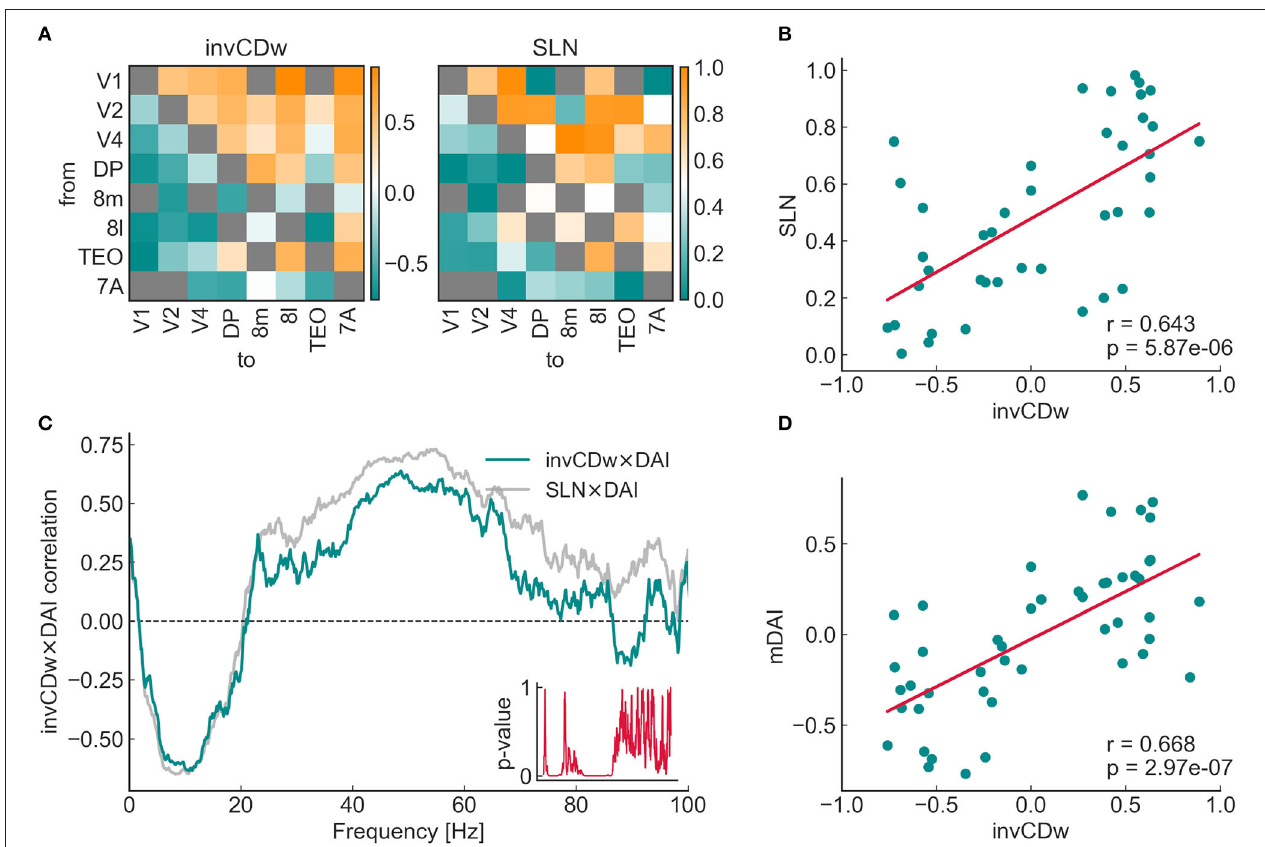
FIGURE 6 | Relationship of the additive inverse of the weighted convergence degree (invCDw) with the SLN (fraction of supragranular labeled neurons) and the DAI (directed influence asymmetry index, see the main text for complete descriptions) in the 8 × 8 subgraph. (A) The invCDw and the SLN matrices of the 8 × 8 subgraph, the latter based on the data from Markov et al. (2014), as in Mejias et al. (2016). Both distributions are highly asymmetric. Both are ordered according to the anatomical (SLN-based) hierarchy, therefore it shows that for this subgraph, convergent edges highly coincide with feedforward connections (upper triangle from the diagonal), while divergent edges coincide with feedback connections (lower triangle). It is also clear just by looking at the color distributions, that area TEO would be much lower, while frontal eye field areas 8m and 8l would be higher according to the CD-based ranking. Gray cells are NaNs, where there is no edge in the graph. (B) There is a significant positive correlation between the SLN and the invCDw ( p < 10 − 5 ). Note that invCDw was derived solely from the topology of the weighted network; neither SLN, nor DAI were used in its calculation. Note also that except omitting extreme SLN values (0 and 1) similarly to Mejias et al. (2016), no outlier exclusion was done in any of the plots in this work. (C) Spearman rank correlations for the invCDw and the DAI (green line) and the SLN and the DAI (gray line, a reproduction of results by Mejias et al., 2016) as functions of frequency. The inset shows the p-values. The invCDw shows a significant negative correlation in the alpha-band and a significant positive correlation in the gamma-band similar to that found for the SLN. Interestingly, the invCDw shows almost the exact level of correlation in the alpha-band (for feedback connections) as the SLN, whereas in the gamma-band (for feedforward connections) it is somewhat lower. (D) There is a significant positive correlation between the invCDw and the multifrequency DAI (mDAI, p < 10 − 6